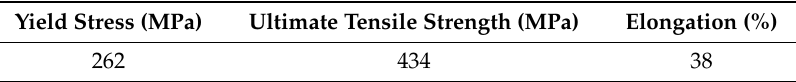
Table 4. Mechanical properties for ASTM A36 steel.